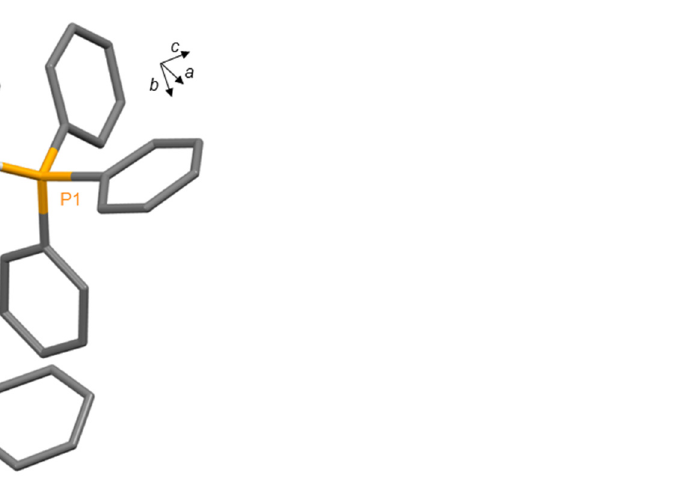
Figure 20. Molecular structure of 17 , adapted from [73] (MERCURY view). Hydrogen atoms are omitted for clarity (Sn light blue, O red, P orange, Fe white, C grey).